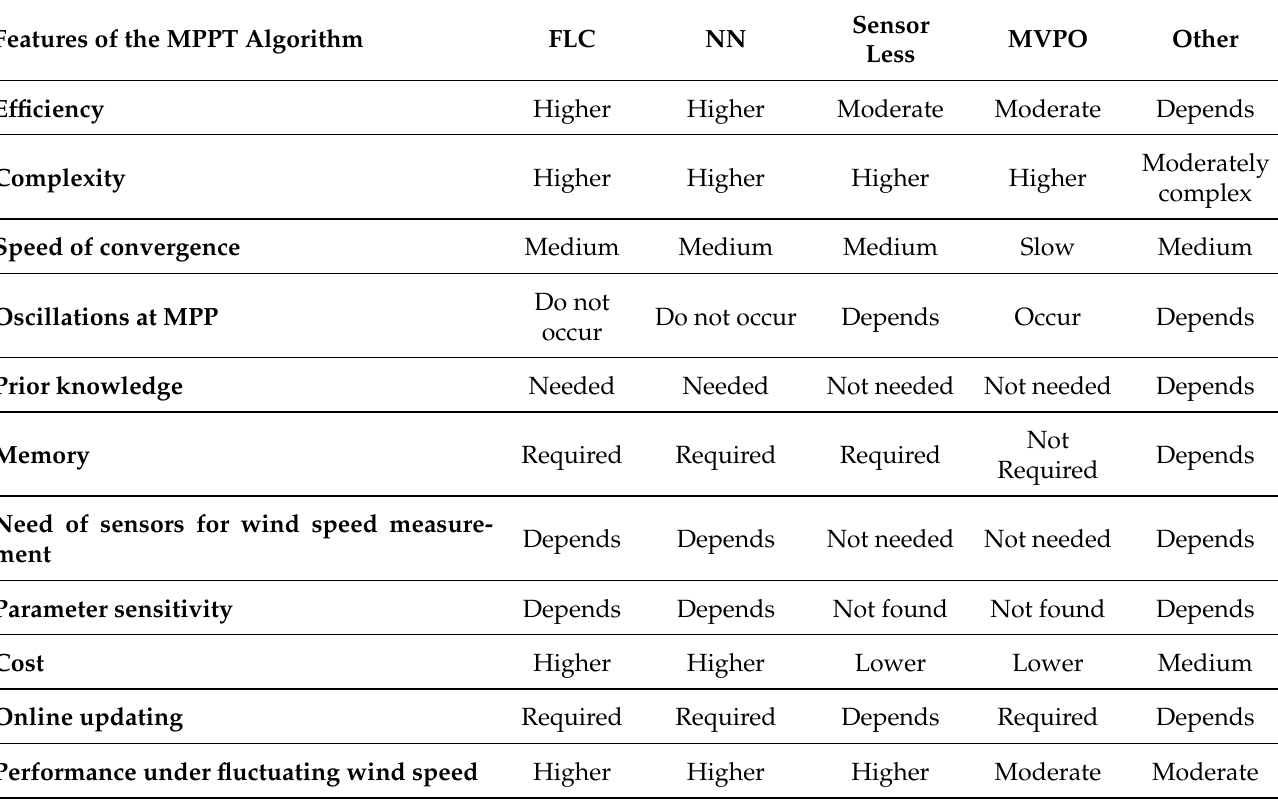
Table 7. Comparison of Smart MPPT Algorithms for WECS. Reused with permission from ref. [34,35,68,128,129]. Copyright 2011, 2015, 2016